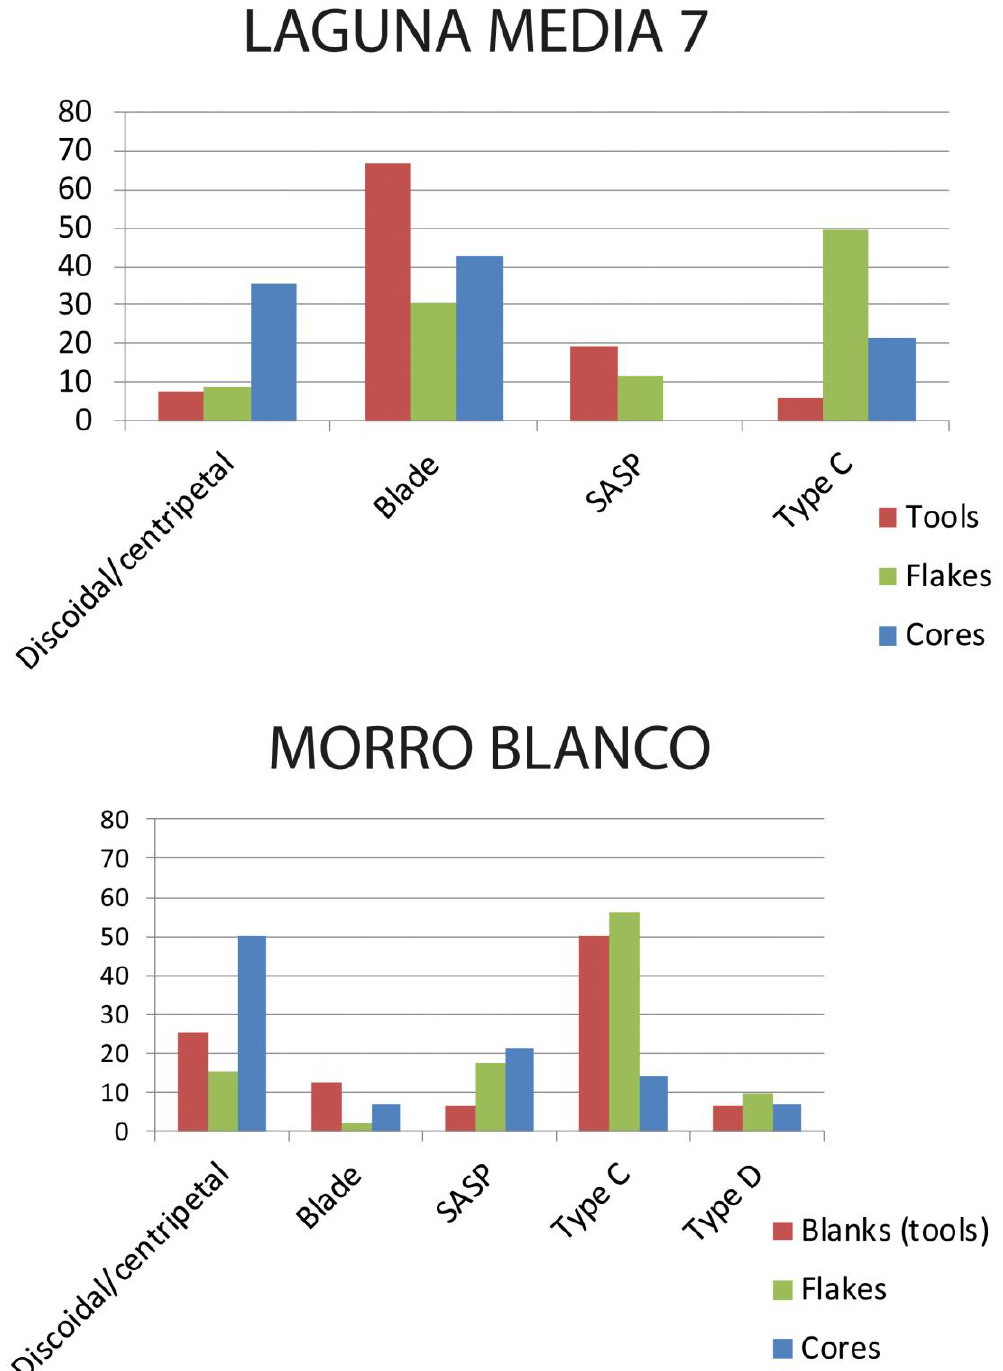
Figure 13. Distribution (percentages) of knapping by-products on Laguna Media 7 and Morro Blanco. Finally, comparing the knapping methods from both sites, the x 2 result (Table 8) was particularly relevant, therefore rejecting the null hypothesis of association between both distributions (x 2 , p<0,001 p=3,68E-26), which also supported the Monte Carlo approximation (p=0,0001). The normalized residuals confirmed the previous observations, as blade knapping represented a weight class in this analysis, being much more represented in Laguna Media 7 than in Morro Blanco. On the other hand, D type cores, were significant and relevant in Morro Blanco, while completely absent in Laguna Media